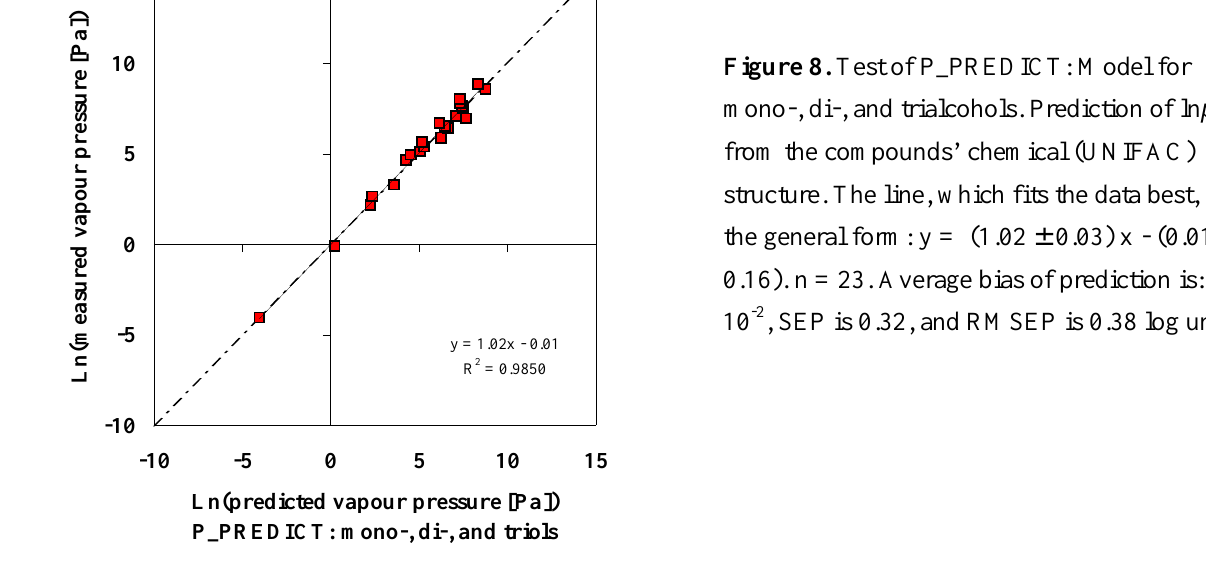
Figure 8. Test of P_PREDICT: Model for mono-, di-, and trialcohols. Prediction of ln p from the compounds’ chemical (UNIFAC) structure. The line, which fits the data best, is of the general form: y = (1.02 ± 0.03) x - (0.01 ± 0.16). n = 23. Average bias of prediction is: 7.0 10 -2 , SEP is 0.32, and RMSEP is 0.38 log units.